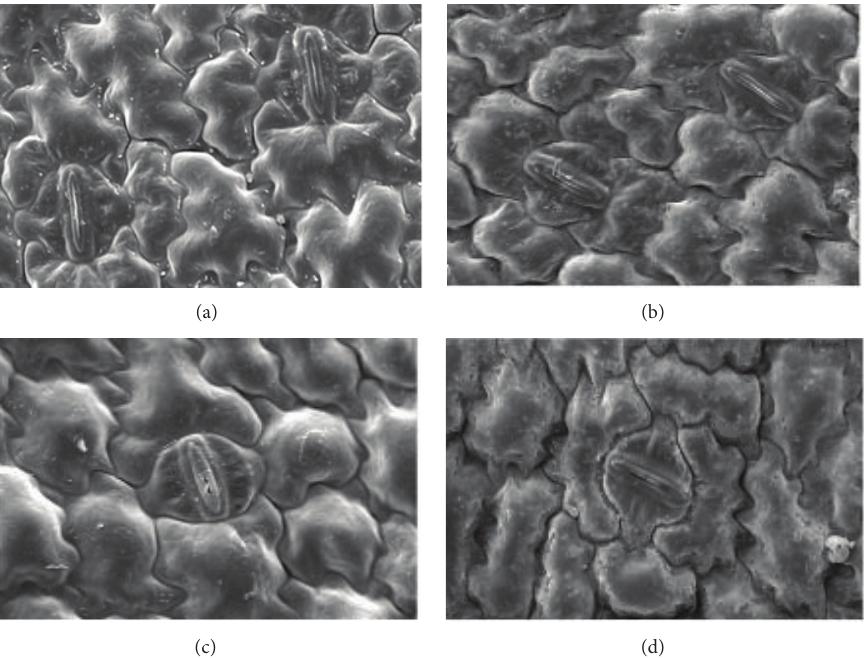
Figure 5: Scanning electron micrograph showing abaxial (a) and adaxial (c) surfaces of in vitro leaves of plantlet of Calathea crotalifera , abaxial (b) and adaxial (d) surfaces of leaves from in vivo (acclimatized) plant.